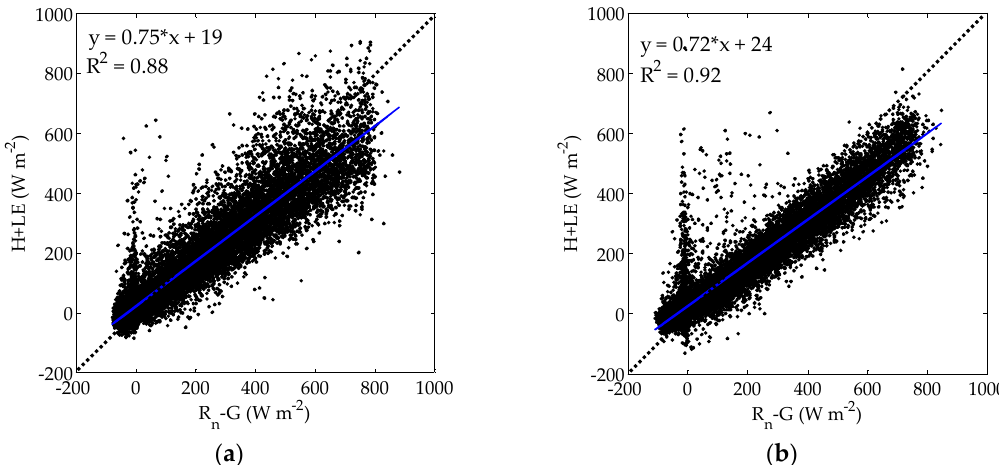
Figure 4. Scatterplots of the half-hour energy balance closure: the available energy (R n − G) vs. turbulent heat fluxes (H + LE) at ( a ) SMA and ( b ) PAS. The solid blue line represents the linear fit of the data. For reference, the 1:1 line is also shown (dashed black line).